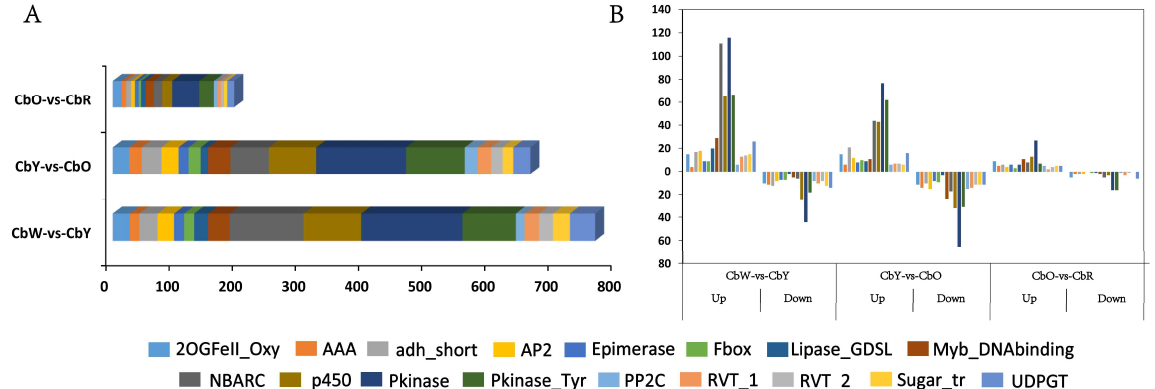
Figure 4. Transcription factor analysis. ( A ) Distribution of transcription factor families in the three comparative combinations of CbW-vs-CbY, CbY-vs-CbO and CbO-vs-CbR. ( B ) Number of up- and down-regulated transcription factor family members in three comparative combinations of CbW-vs-CbY, CbY-vs-CbO and CbO-vs-CbR.